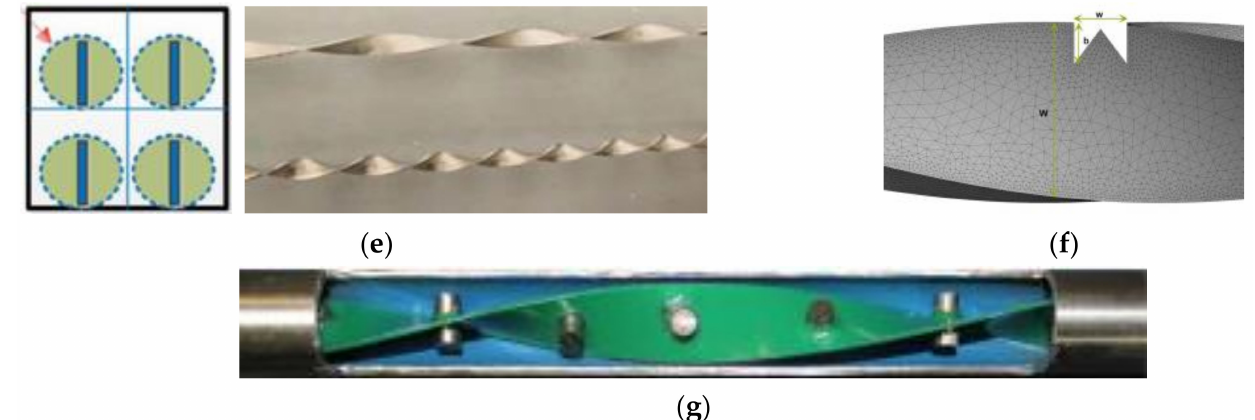
Figure 1. The modified twisted tapes for enhancing the heat transfer in heat exchanger tubes in relevant works. ( a ) square-cut twisted tape [21]. ( b ) constant-increased-PR twisted tape [22]. ( c ) clockwise counter-clockwise twisted tape [23]. ( d ) perforated and dimpled twisted tape [24]. ( e ) multiple twisted tapes [25]. ( f ) W-cut twisted tape [27]. ( g ) rod-inserted twisted tape [26].